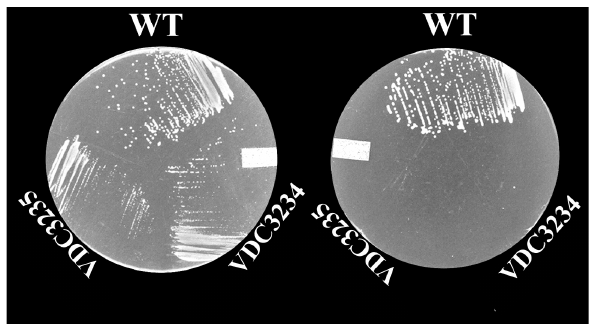
Figure 5. Haloferax volcanii folE2 deletion mutant phenotype analy- sis. H26, VDC3234 and VDC3235 (two HVO_2348 independent deletion mutants) growing on Hv-CA supplemented with dT/hypo- xanthine (left plate) or hypoxanthine only (right plate) (pantothenate was added to both plates). Cells were grown at 45 °C for 72 hours.